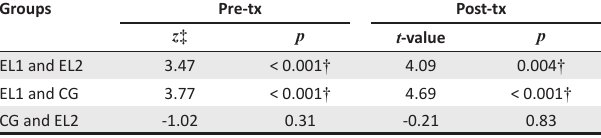
difference between the scores of the EL1 and the EL2 groups TABLE 10: Results for significant differences in spelling scores between groups.